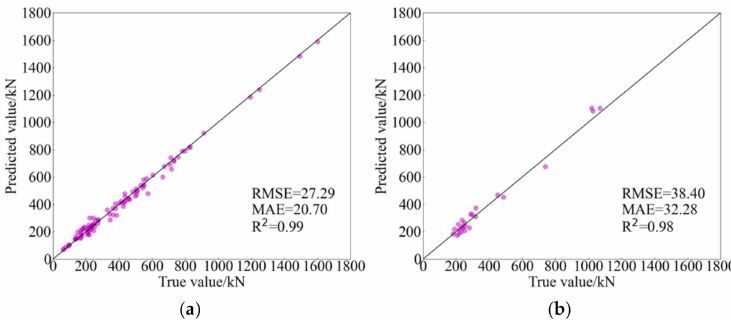
Figure 6. The predictions of DT for data set. ( a ) Training set; ( b ) Test set.